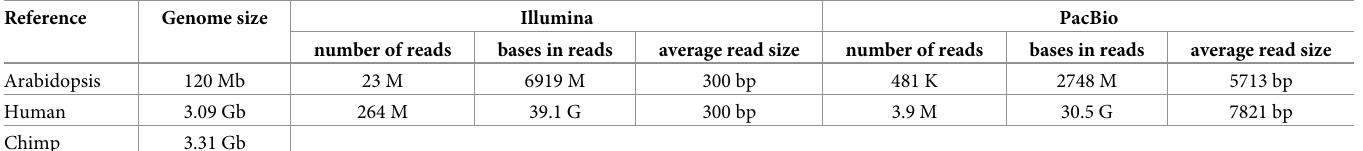
Table 2. Description of the data sets used for aligner comparisons. The Illumina and PacBio data for A. thaliana is available from [23]; the human Illumina and PacBio reads are from the Ashkenazi child data set (available from the Genome in a Bottle project [24], NCBI SRA accession SRX847862). The reference genomes are the Arabi- dopsis thaliana Col-0 reference genome [18], the human reference genome version GRCh38.p7 [19], and the chimpanzee ( Pan troglodytes ) genome [20] (release PanTro4, GenBank accession